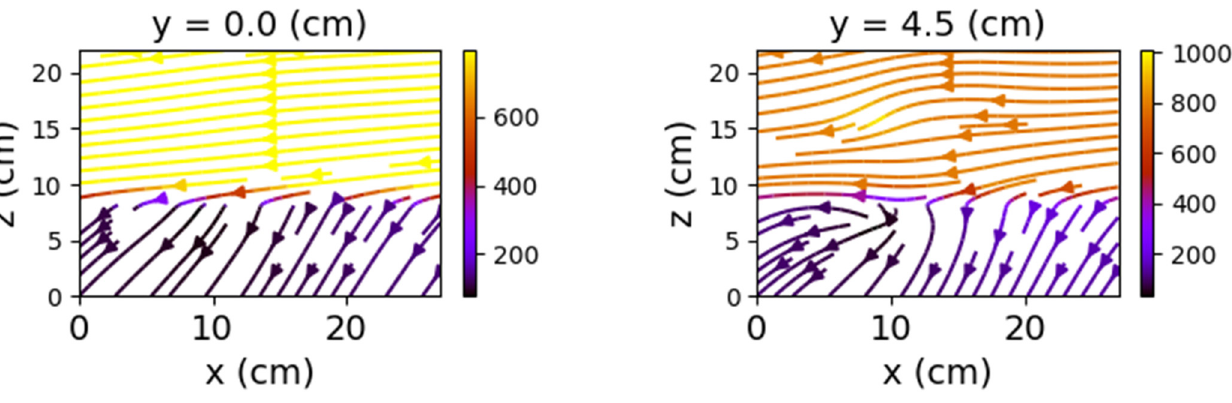
Figure 13. Field lines for x O z plane—relay with both coils powered.